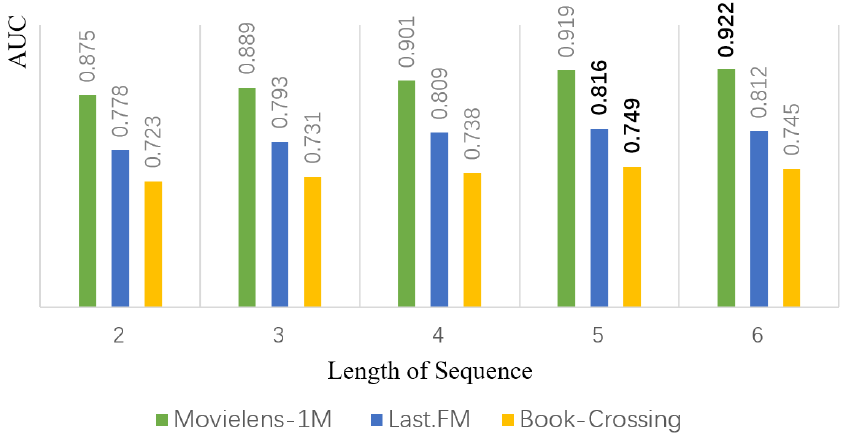
Figure 5. Performance in Different Lengths of Sequence.